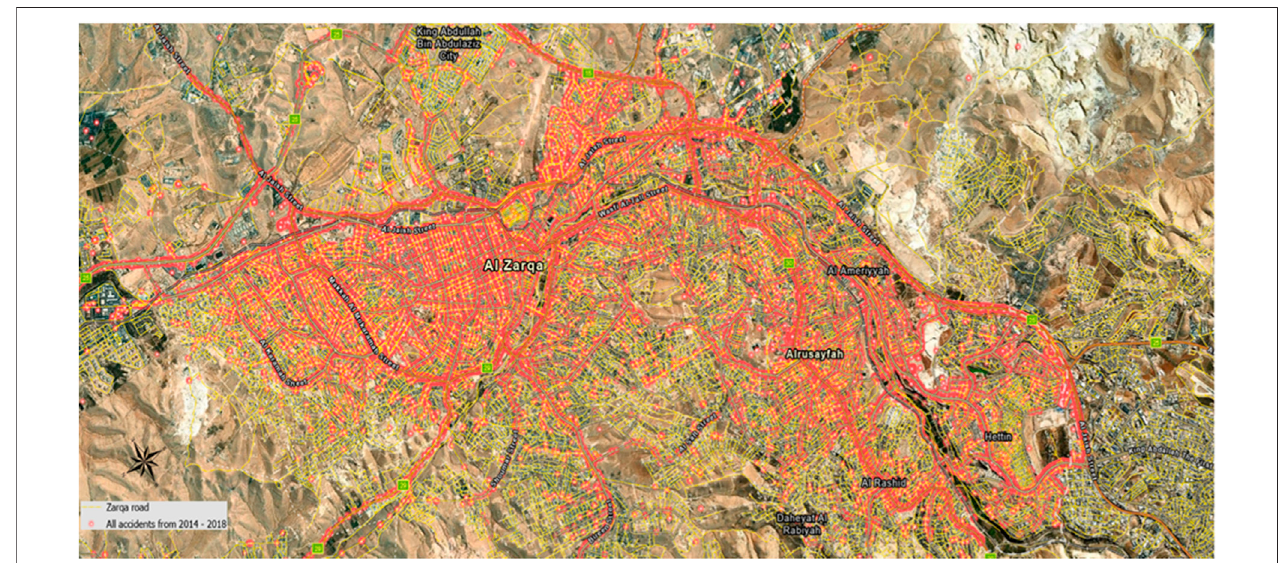
FIGURE 1 | Traf fi c accidents from 2014 to – 2018 occurred in Zarqa